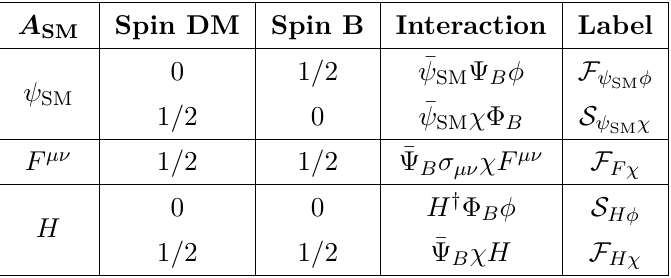
Table 1. Classification of the simplest possible operators featuring a cubic interaction of the type of figure 1. The DM particle is a SM singlet denoted by φ if it is a scalar, χ if it is a fermion. The bath field ( Ψ for fermions, Φ for scalars) has therefore the same quantum numbers as the B B corresponding SM field A . See the text for further SM